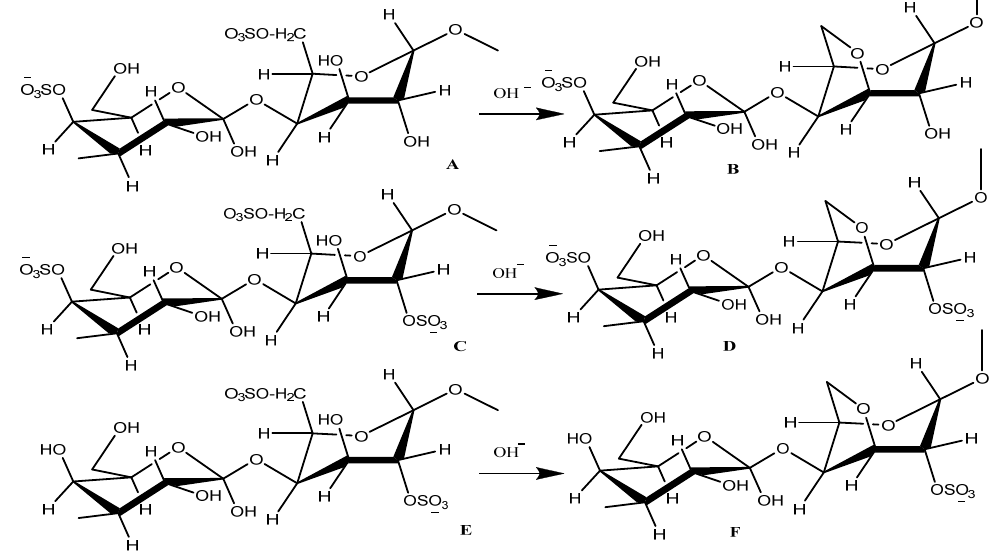
Figure 1. Six types of carrageenan. A = μ - carrageenan, B = κ - carrageenan, C = ν - carrageenan, D = ι - carrageenan, E = λ - carrageenan and F = θ - carrageenan.